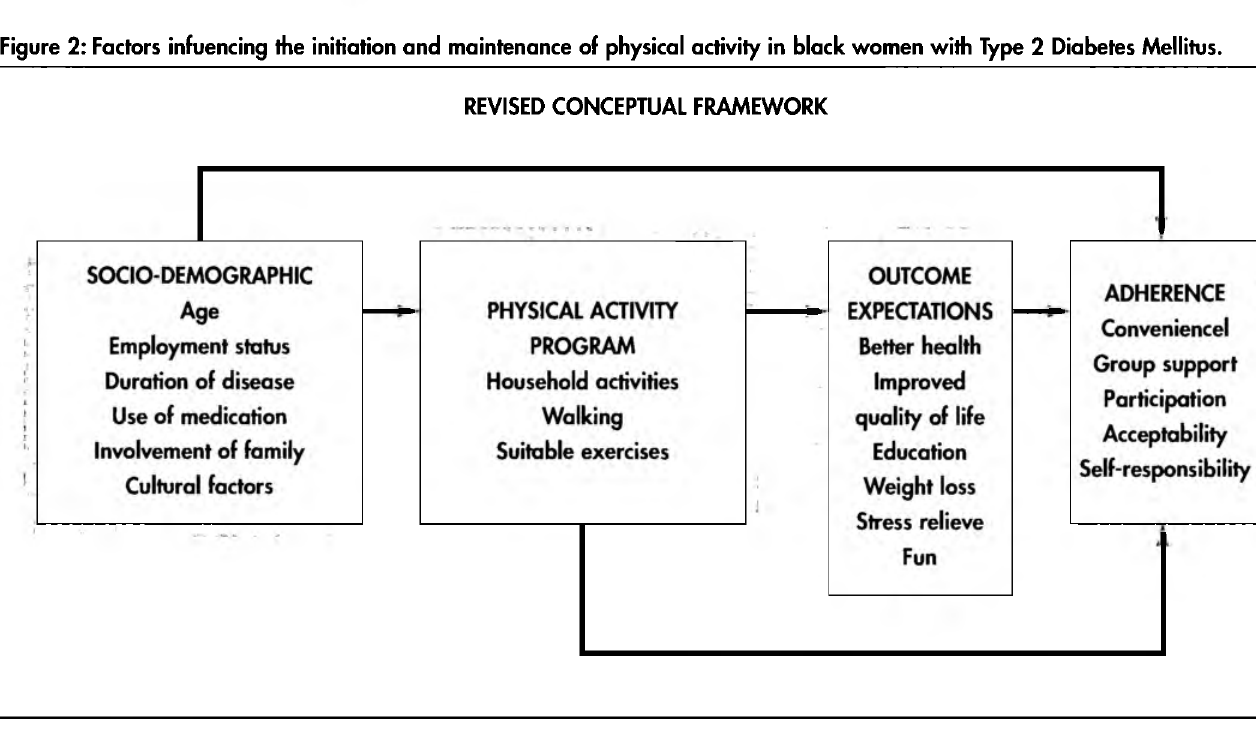
Figure 2: Factors infuencing the initiation and maintenance of physical activity in black women with Type 2 Diabetes